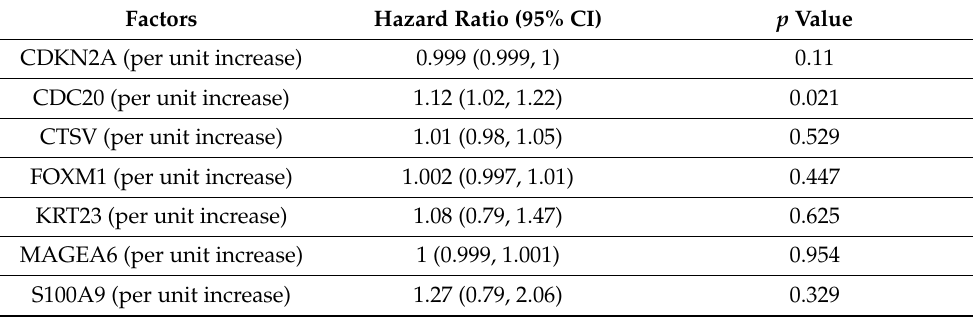
Table 6. Univariate analysis of gene expression on progression free survival using Cox model.